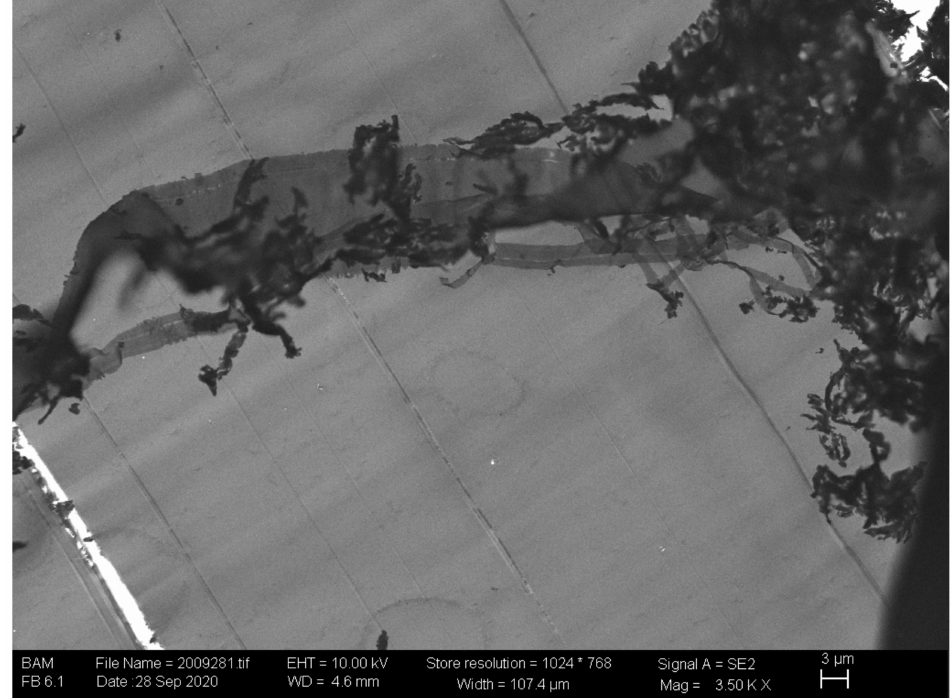
Figure A3. Scanning electron image in transmission mode (TSEM) of the epoxy composite with crossing collapsed PC neat fibers, which appear as slightly darker ellipsoidal structures. The darker structures are shreds from the sample resulting from the ultramicrotome